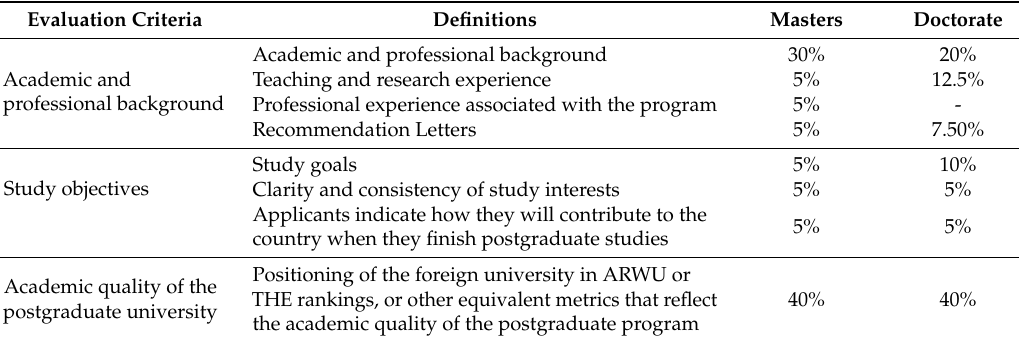
Table A1. Fellowship evaluation